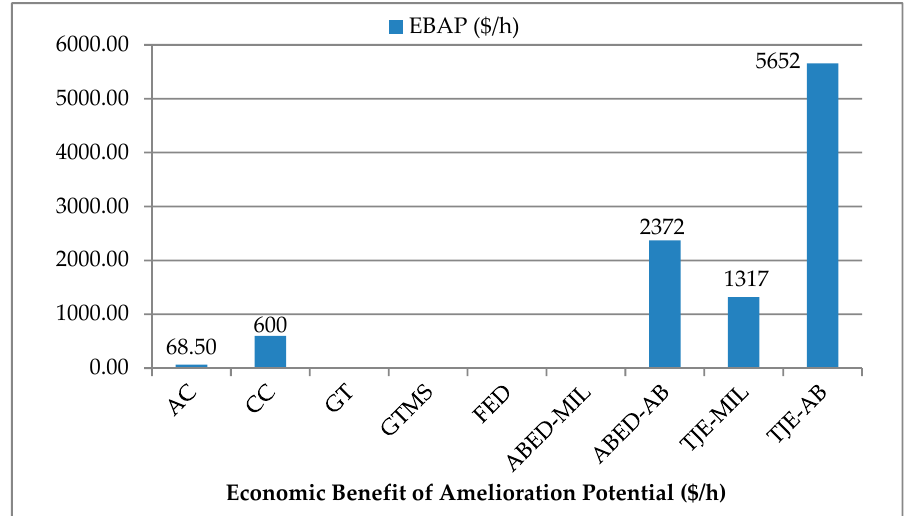
Figure 7. Economic benefit of amelioration potential (EBAP) with H 2 fuel usage.